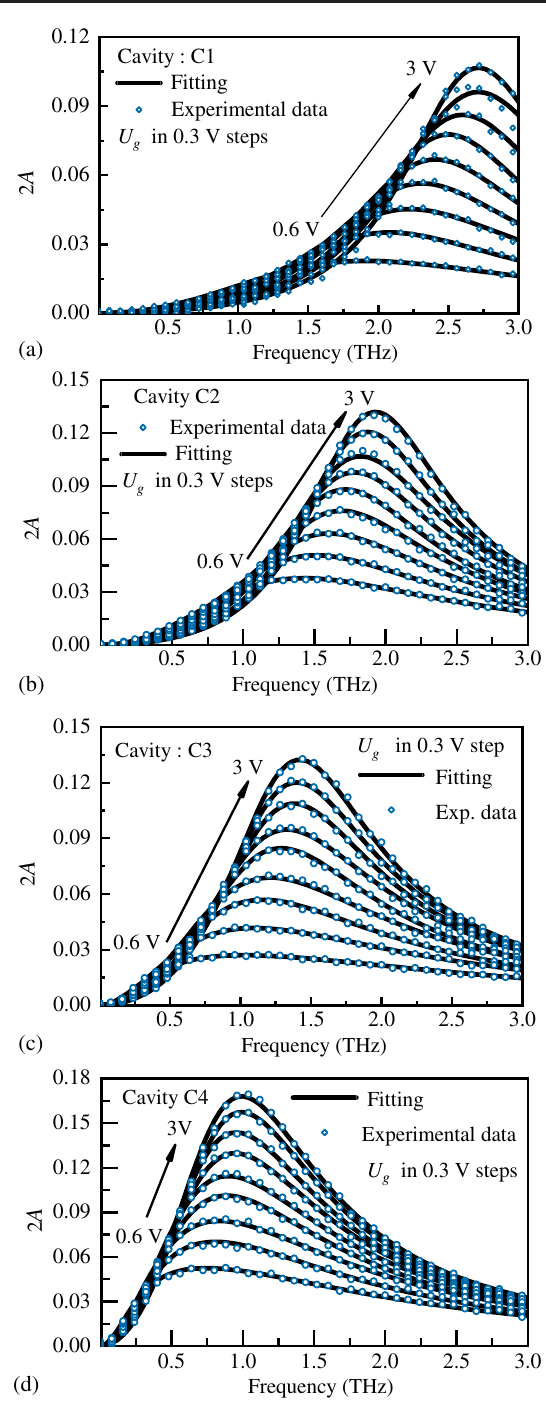
FIG. 6. Gate-voltage-dependent extinction spectra of the ¼ 0 V with incident light polar- graphene structures for U d ized perpendicular to the gate fingers. Panels (a), (b), (c), and (d) presents results for C 1 , C 2 , C 3 , and C 4 cavities, correspondingly. The experimental data are marked as dots, and continuous lines are the results of fits using standard physical models of gated 2D plasmons in graphene.